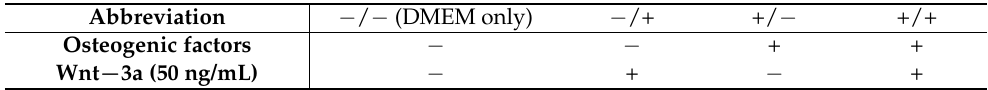
Table 1. Classification of culture medium.